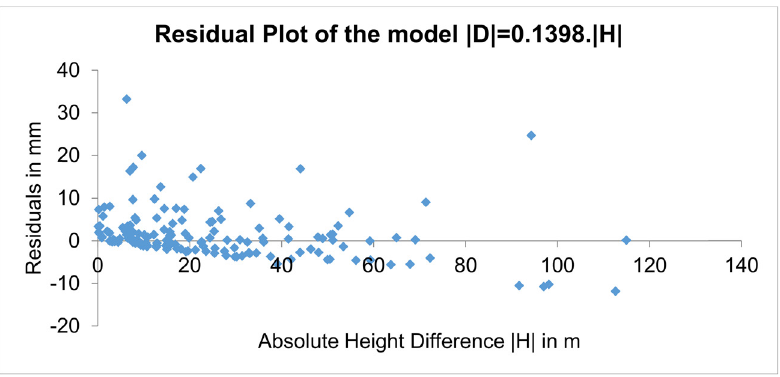
Figure 2: Pattern of the residuals of the regression model | D | = 0.1398 | H | , where | D | denotes the absolute di ff erence between both measurements of the absolute value of the height | H | between the terminals of a line. The regression model is based on 146 lines given by Kääriäinen ( 1966, Table IX ) .